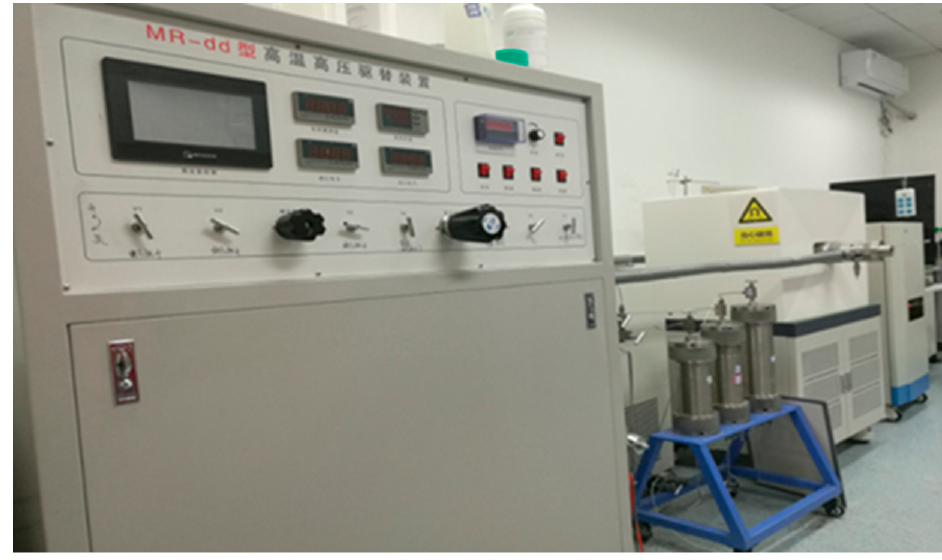
Figure 1. Diagram of low-field nuclear magnetic resonance displacement device.